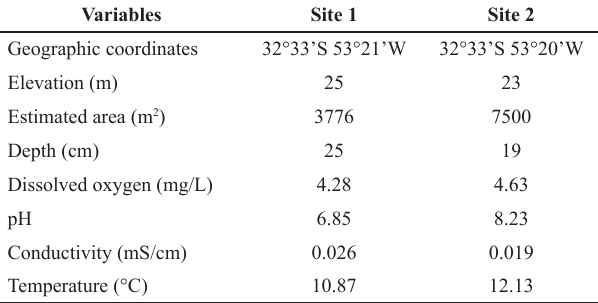
Table 1. Environmental and water characterization of sampling sites of Austrolebias cheradophilus populations found in Jaguarão River basin, Patos-Mirim Lagoon system, southern Brazil.